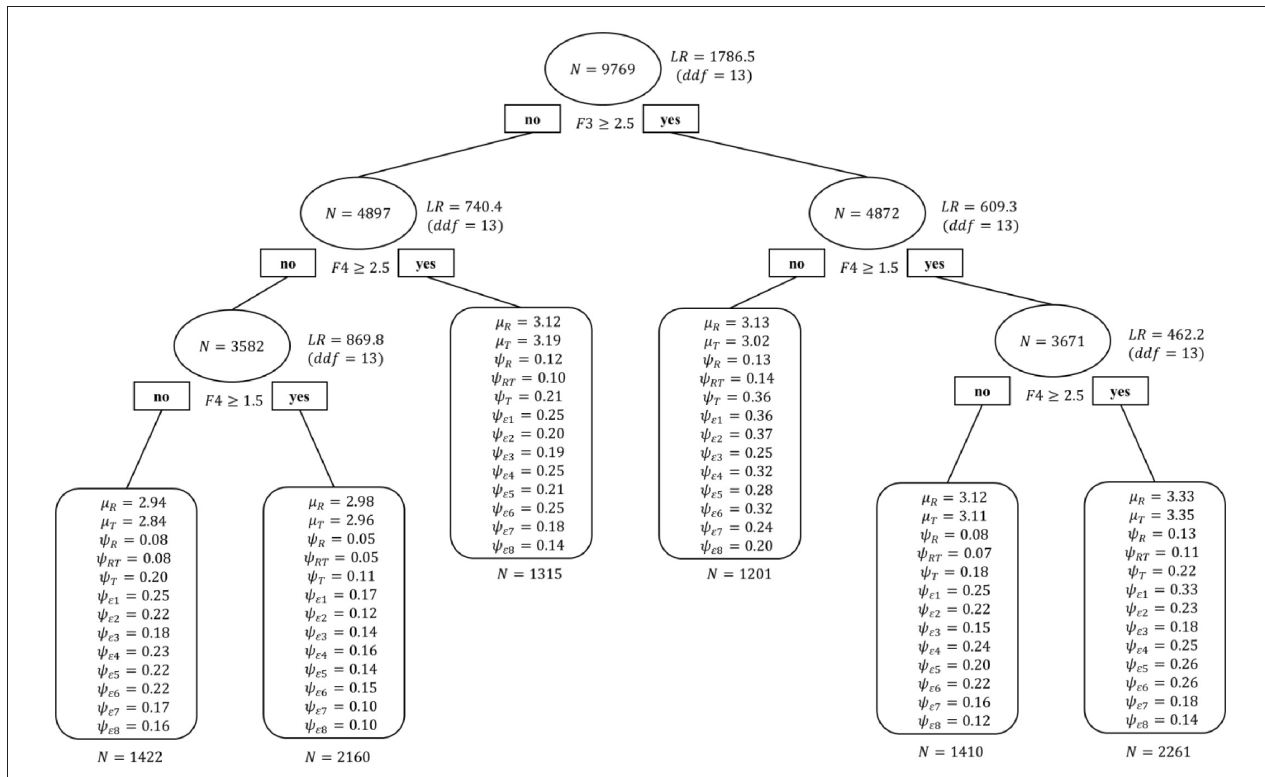
FIGURE 3 | Complete SEM Tree for students’ attitudes toward collaboration. N , sample size at each split; LR , likelihood-ratio statistic; ddf , difference in degrees of freedom; F3, achievement motivation; F4, the sense of belonging at school. Each parameter label corresponds to the estimate for that group from the two-factor model depicted in Figure 1B